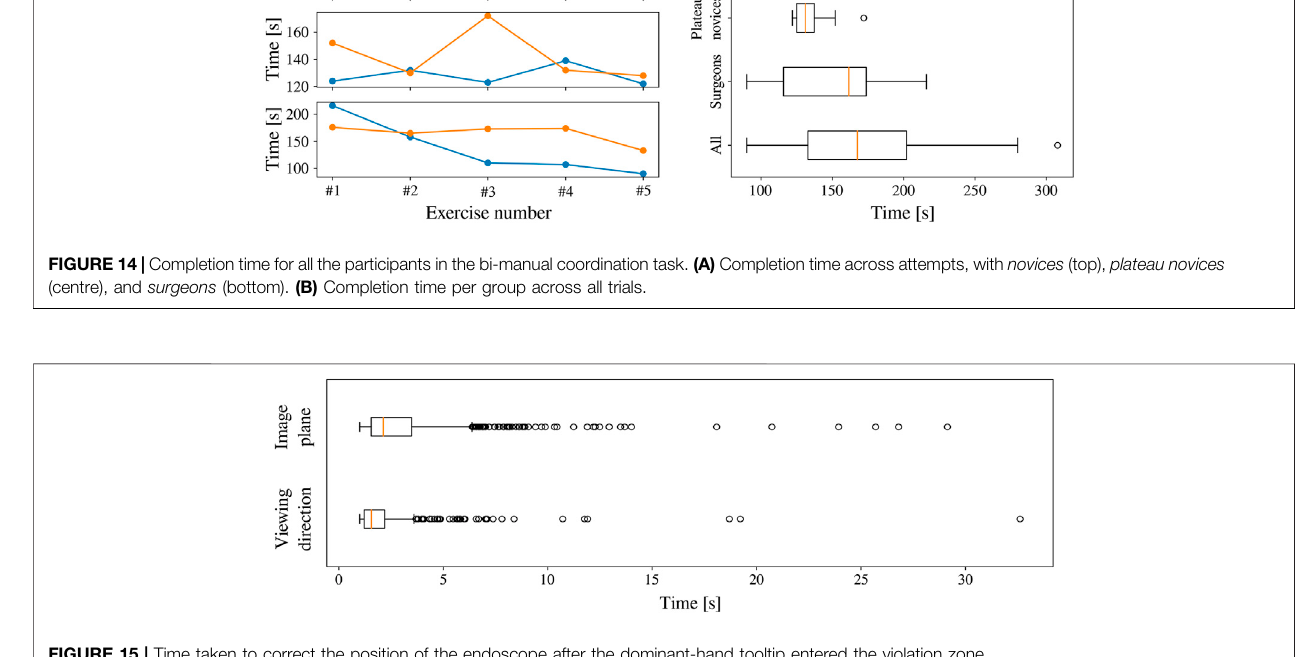
FIGURE 15 | Time taken to correct the position of the endoscope after the dominant-hand tooltip entered the violation zone.